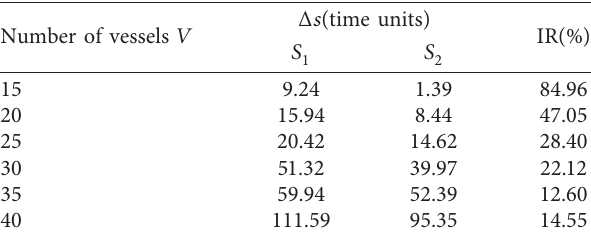
Table 4: Average performances of solutions to 1000 scenarios. Number of vessels V